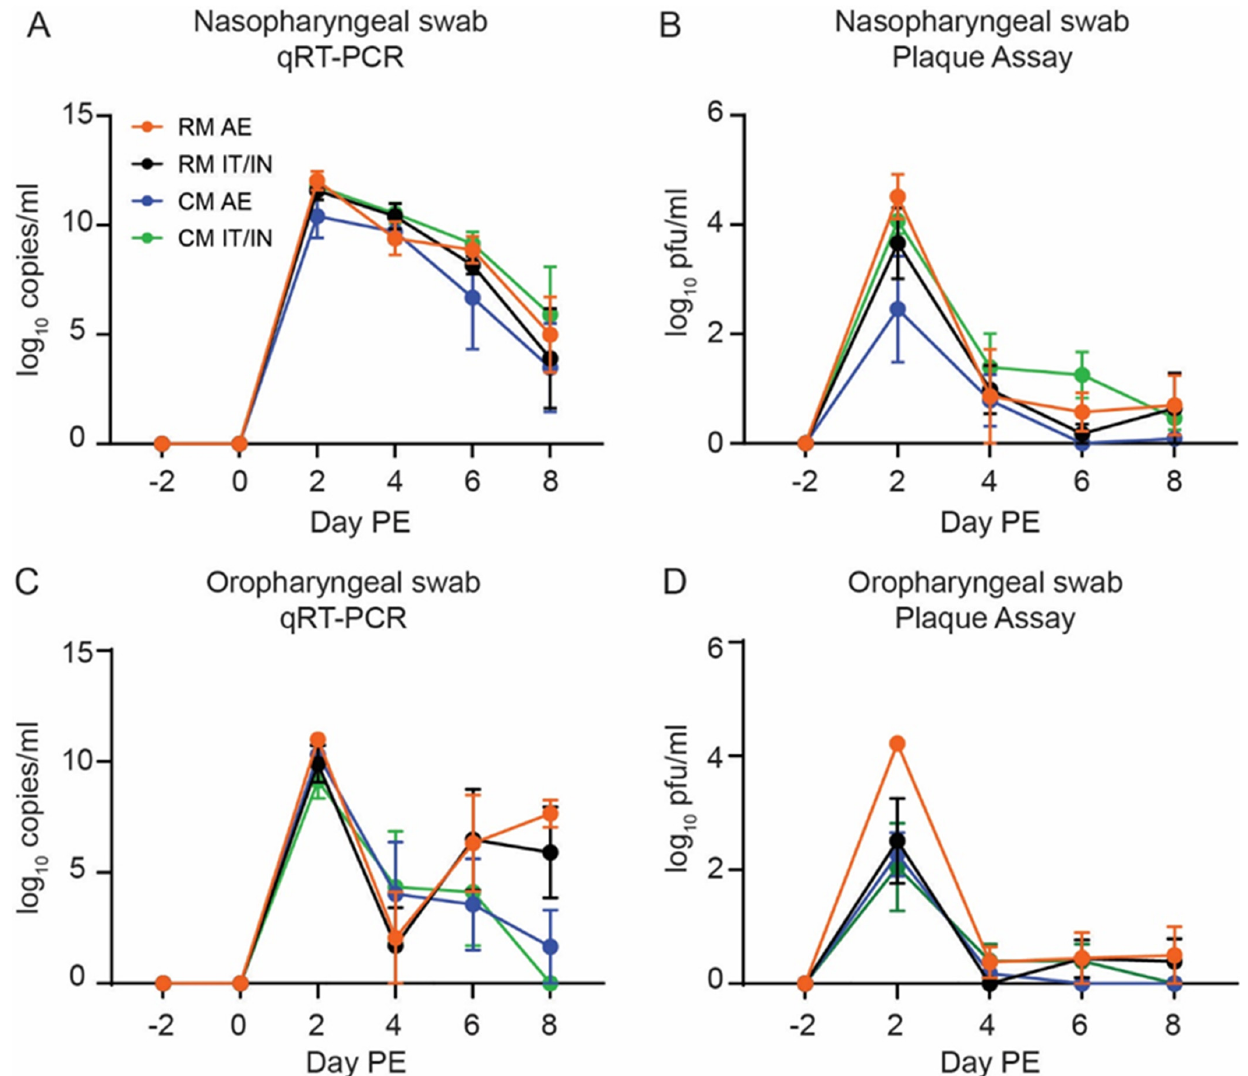
Figure 2. Infection of rhesus (RM) and cynomolgus macaques (CM) with SARS-CoV-2 by aerosol (AE) or intratracheal/intranasal (IT/IN) exposure. Detection of viral RNA in NP swabs ( A ) and OP swabs ( C ) by qRT-PCR. Detection of infectious virus by plaque assay in NP swabs ( B ) and OP swabs ( D ). Data are shown as the group mean ± SEM. Graphs of individual data points can be found in Figure S7. Table 1. Peak infectious SARS-CoV-2 titers for nasopharyngeal (NP), oropharyngeal (OP), and rectal swabs by study group.